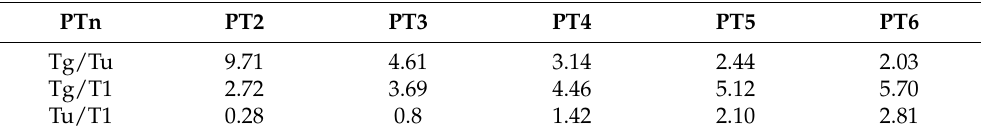
Table 1. Table values, order n and T1 of the n PT1 systems, as a function of the delay time Tu and the rise time Tn